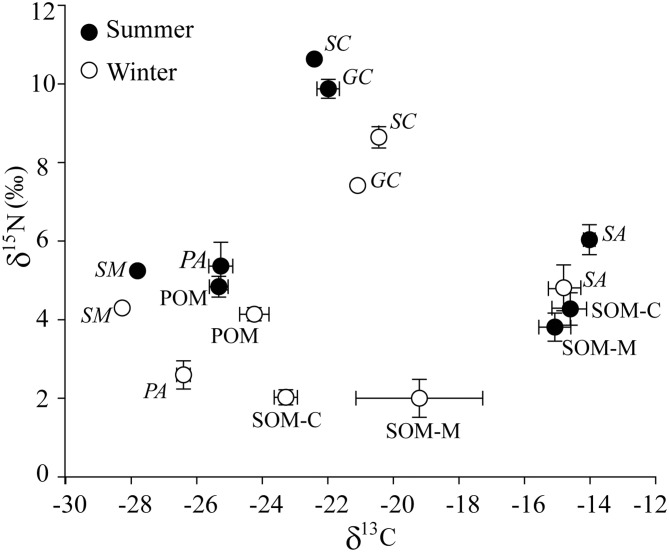
The dual isotope plot of δ13C and δ15N signatures (mean ± SE) of food sources and bivalves.
SC and GC represent two bivalve species Sinonovacula constricta and Glauconome chinensis, respectively. SM, PA and SA represent three plant species of Scirpus mariqueter, Phragmites australis and Spartina alterniflora respectively. POM: particular organic matter. SOM: sediment organic matter. SOM-C and SOM-M represent SOM from the creek and the marshes respectively. Samples taken in summer or winter are indicated with filled or open symbols.